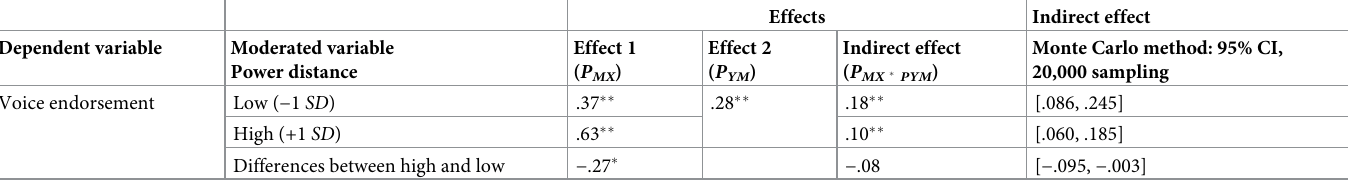
Table 3. Moderated mediation effect of team level power